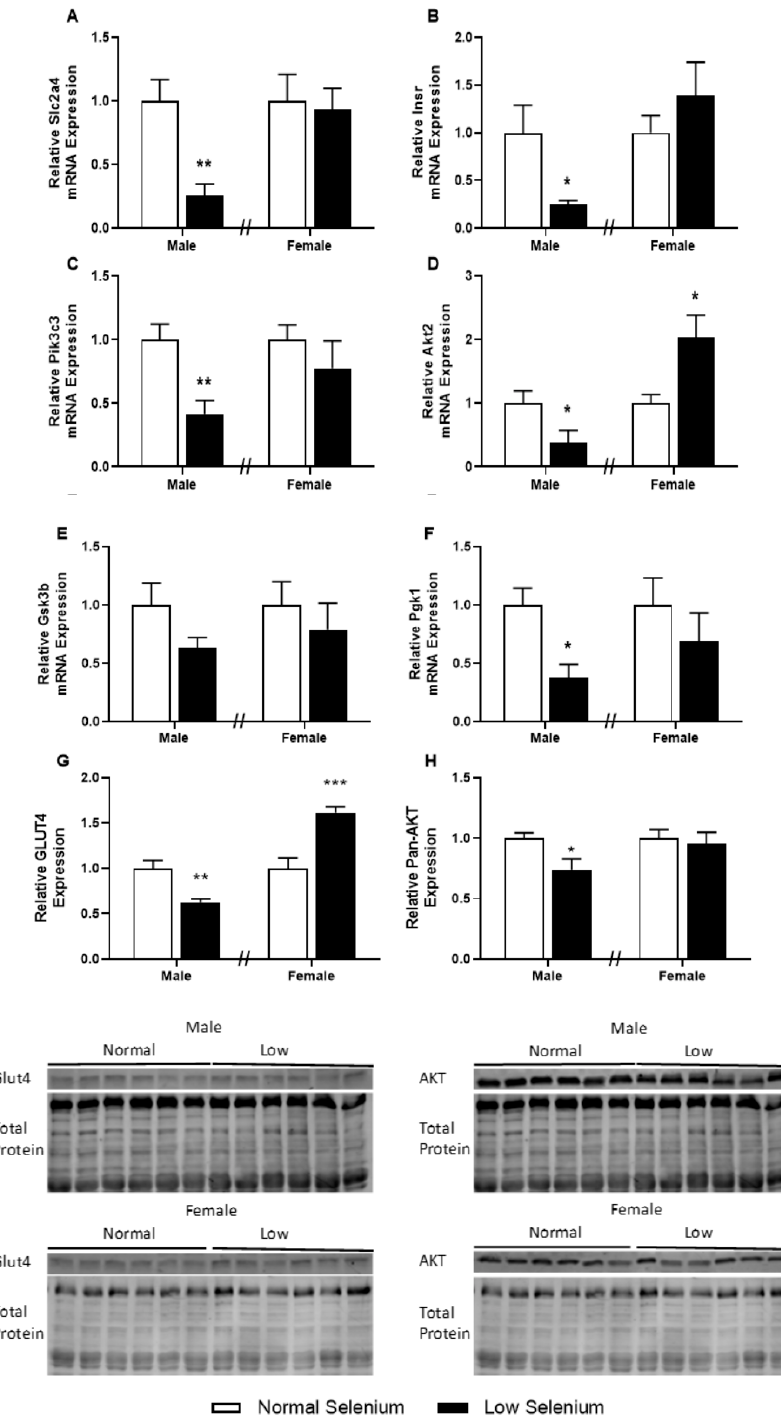
Figure 4. Insulin receptor pathway in the skeletal muscle of offspring. PN180 insulin receptor pathway mRNA and protein expression in the gastrocnemius. Expression of ( A ) Slc2a4 , ( B ) Insr , ( C ) Pik3c3 , ( D ) Akt2 , ( E ) Gsk3b and ( F ) Pgk1 in males and females at PN180. Protein expression of ( G ) GLUT4 and ( H ) Pan-AKT is shown in both males and females. Open bars (white) indicate offspring from litters that consumed a normal selenium diet, whereas closed bars (black) are offspring from litters that consumed a low selenium diet throughout pregnancy and up until weaning. Data are mean ± SEM and analysed by unpaired t -tests between mice for litters on a normal selenium diet and a low selenium diet in both males and females. * = p < 0.05, ** = p < 0.01, *** = p < 0.001 compared to control of same sex. n = 6–8.